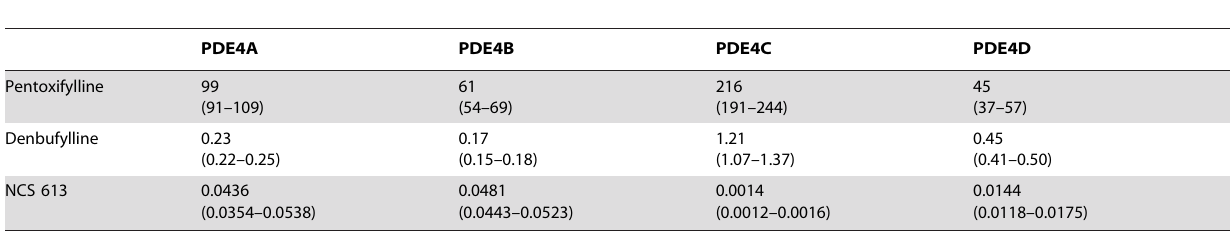
Table 3. IC 50 ( m M) values for pentoxifylline, denbufylline and NCS 613 on human recombinant PDE4